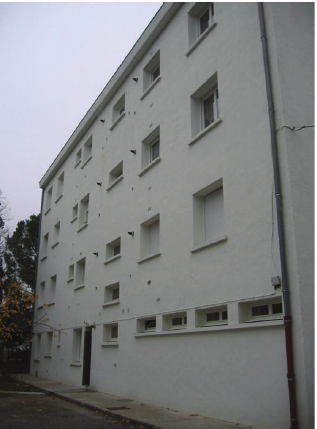
Figure 15: 3D view of the